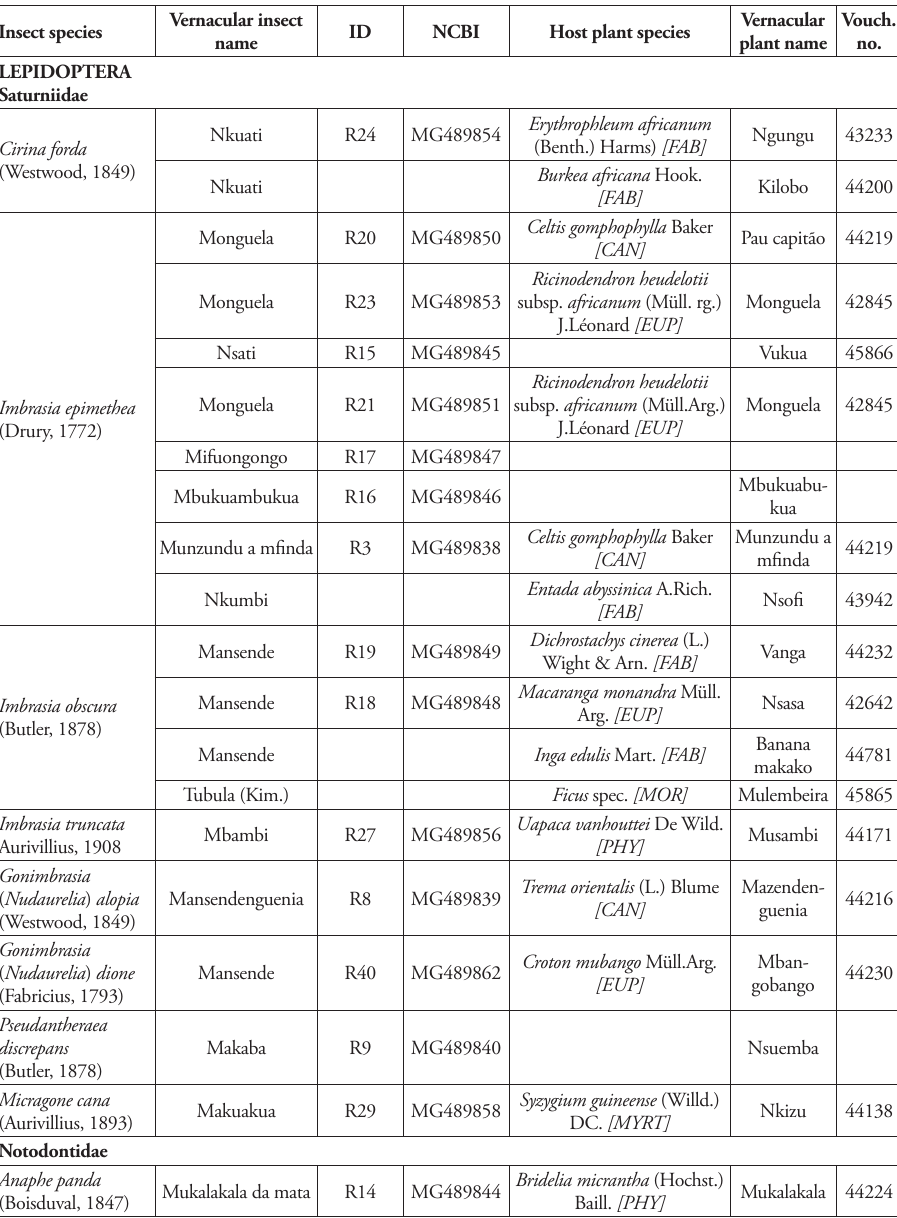
Table 1. Species overview. Scientific and vernacular names of insects and host plants according to local Kikongo dialect, except one name, which is marked with (Kim.) according to Kimbundu language; Plant names according to plantlist.org; plant family in square brackets; [ARE] Arecaceae, [CAN] Cannabaceae , [EUP] Euphorbiaceae , [FAB] Fabaceae , [MOR] Moraceae , [MYRI] Myristicaceae , [MYRT] Myrtaceae , [PHY] Phyllanthaceae , [SAP] Sapindaceae , [STE] Sterculiaceae ; voucher number of herbarium sheets ac- cording to Herbarium Dresdense, vouchers marked with F are photo